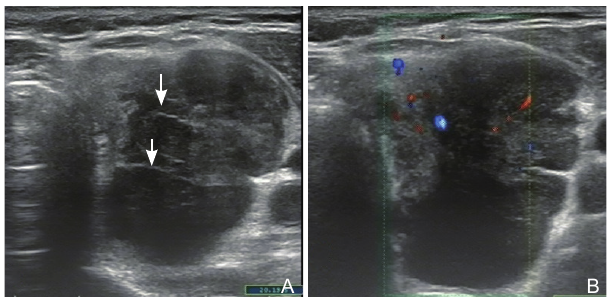
Figure 2 (A) The thyroid nodule of a 63-year-old female, shown as patient No. 6 in the Table 1. With a convex probe in the longitudinal section, the nodule was heterogeneously hypoechoic with an irregular margin and a wider-than-tall shape (horizontal). It was adjacent to the right lower lobe and extended to the substernal region. T shows the right lower lobe of the thyroid. The upward-pointing arrow shows the nodule was adjacent to the right lower lobe and could not be separated from the thyroid. It extended to the substernal region; (B) Mixed blood flow signals were observed within the nodule. The upward-pointing arrow shows the striped hyper-echogenicity within the nodule in the transverse section.